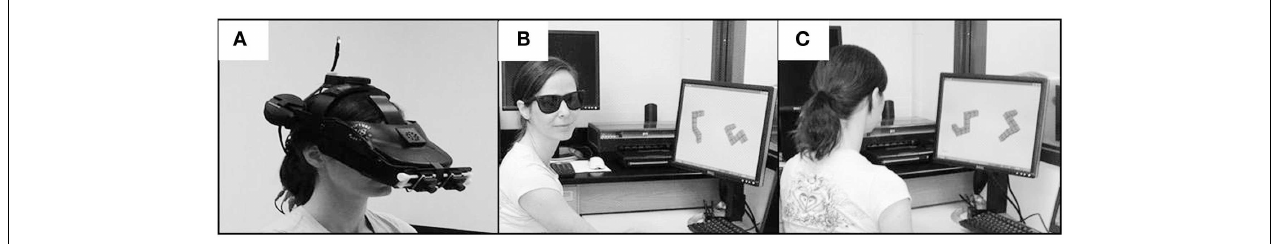
FIGURE 2 |Three different viewing environments (A) 3DI, which includes HMD with position tracking, (B) 3DNI with anaglyphic glasses to present a stereo picture of three-dimensional spatial forms, and (C) 2D monocular viewing